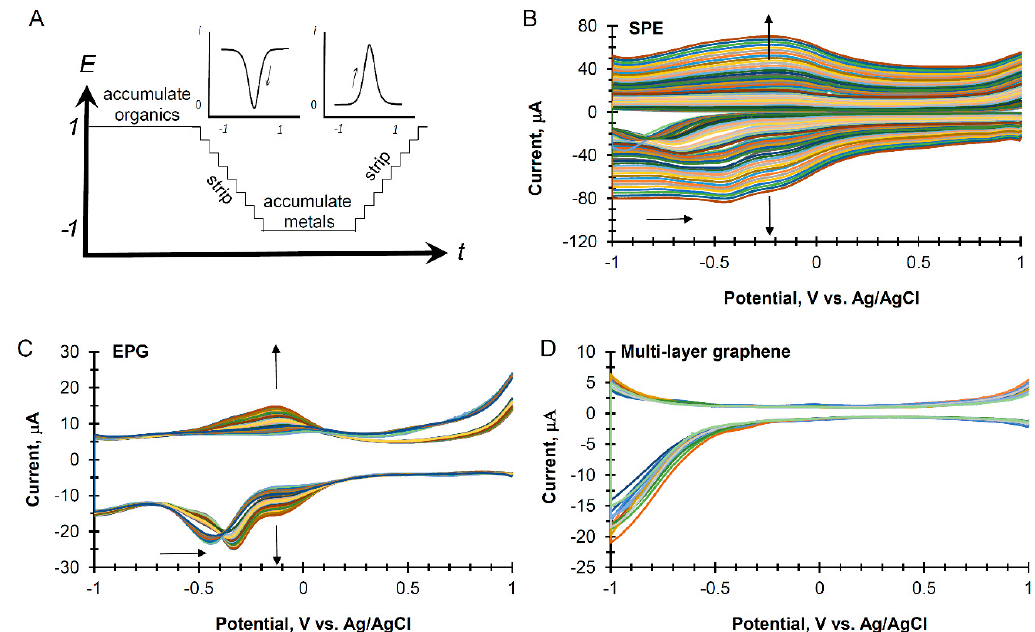
Figure 2. ( A ). Parameters used for cyclic square wave voltammetry including two accumulation steps at two minutes each, a square wave frequency of 17.5 Hz, and a potential range from + 1.0 to − 1.0 V vs. Ag / AgCl. ( B , C ). The continuous scanning of cyclic square wave voltammetry in unspiked seawater using ( B ) a screen-printed carbon electrode (SPE), ( C ) an edge-plane graphite electrode, and ( D ) a multilayer graphene electrode.